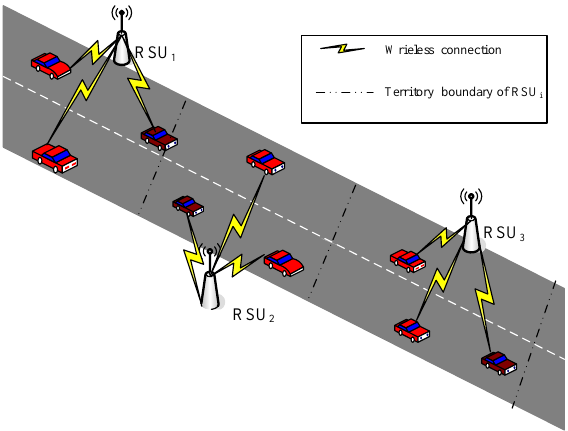
Figure 1. Communication model of our schemes.